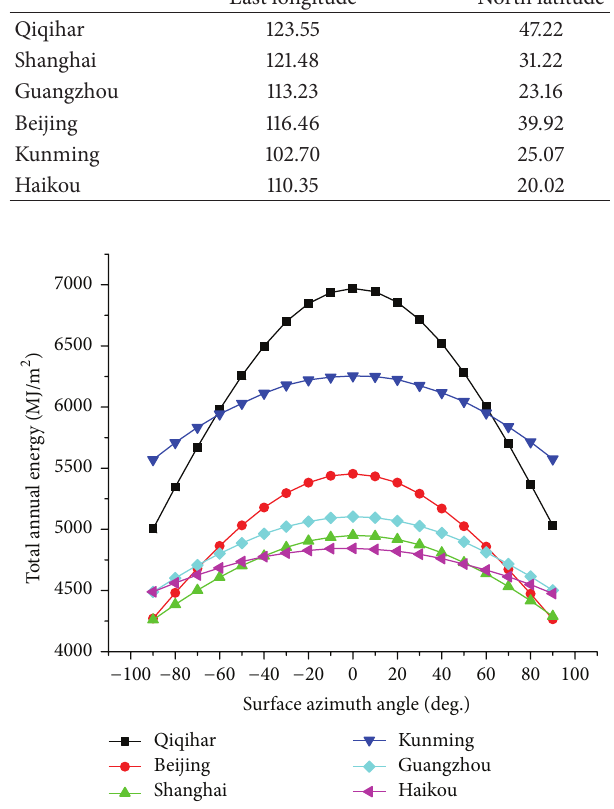
Figure 1: Effect of surface azimuth on collecting radiation in cities with different geographic